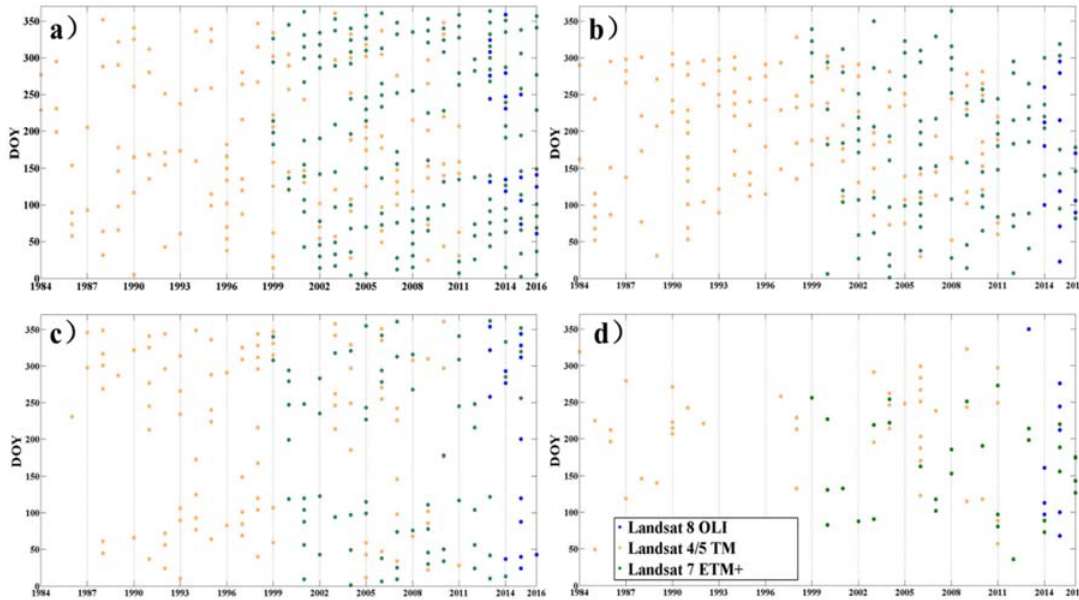
Figure 2. Temporal distributions (DOY, day of year) of adopted Landsat scenes for ( a ) Beijing-123/032; ( b ) New York-130/322); ( c ) Melbourne-93/86; and (d) Munich-193/026.